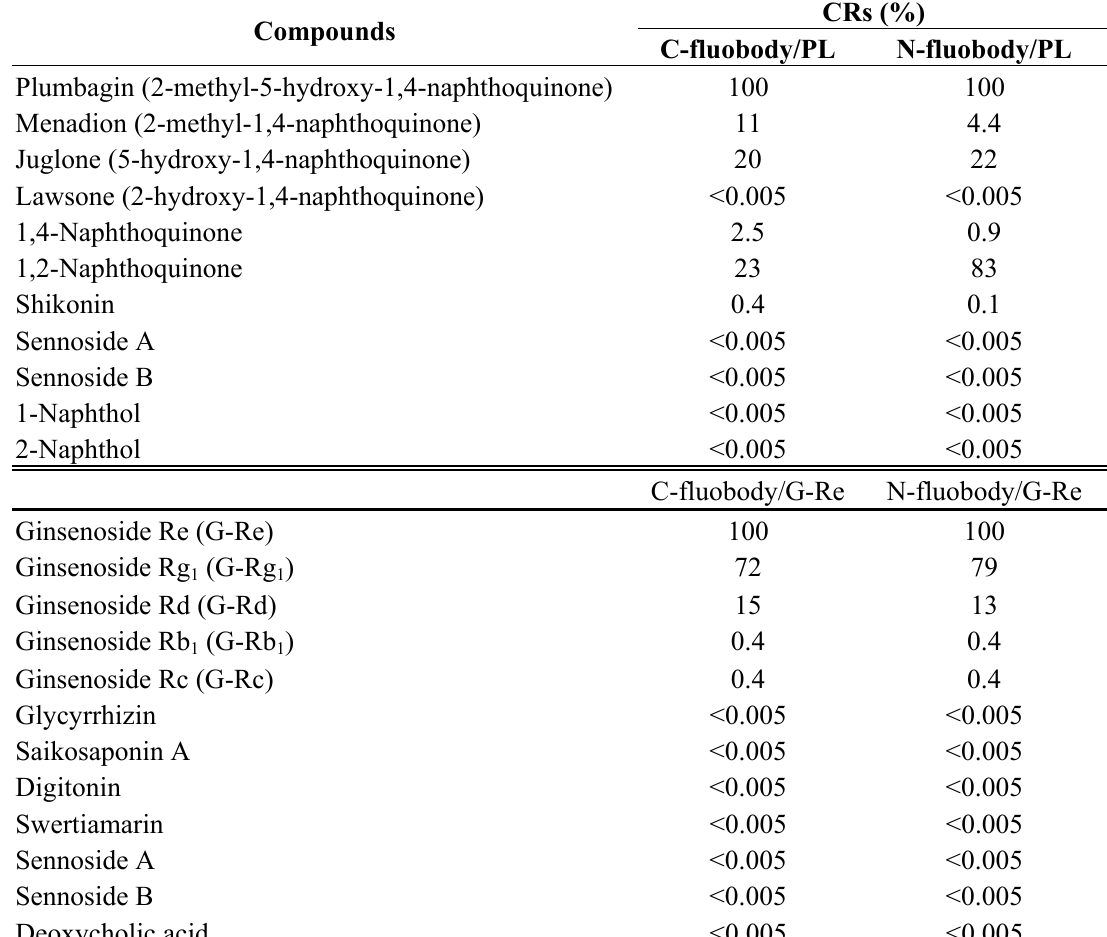
Table 2. Cross-reactivities (CRs) of fluobodies against PL or G-Re. Compounds